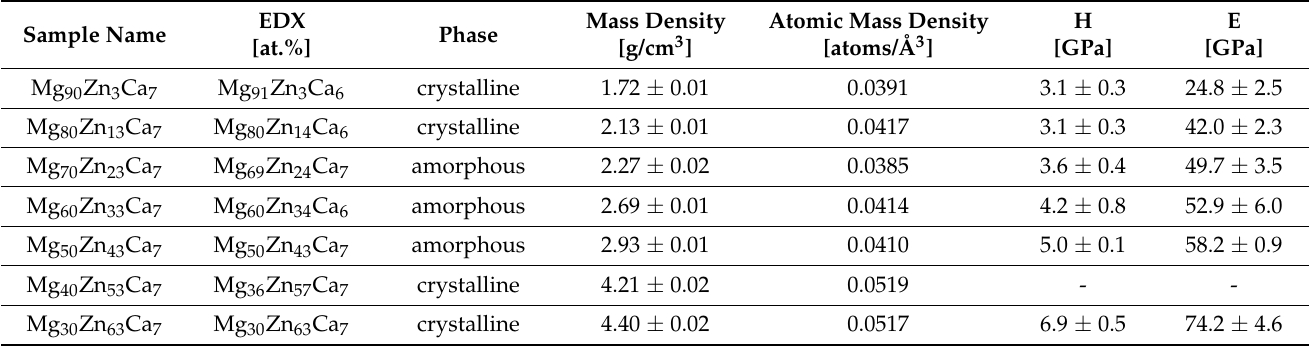
Table 1. Chemical composition, phase, mass density, and corresponding calculated atomic mass